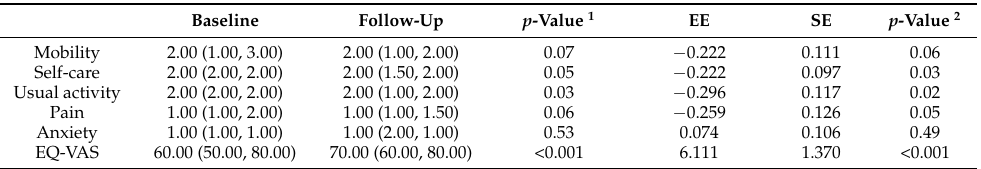
Table 4. EQ-5D-5L single components evaluation and EQ-VAS scores at baseline and follow-up and their estimated change using longitudinal models. Data are reported as the median and interquartile range at baseline and follow-up. Results of the longitudinal model are reported as estimated effect (EE), standard error (SE), and p